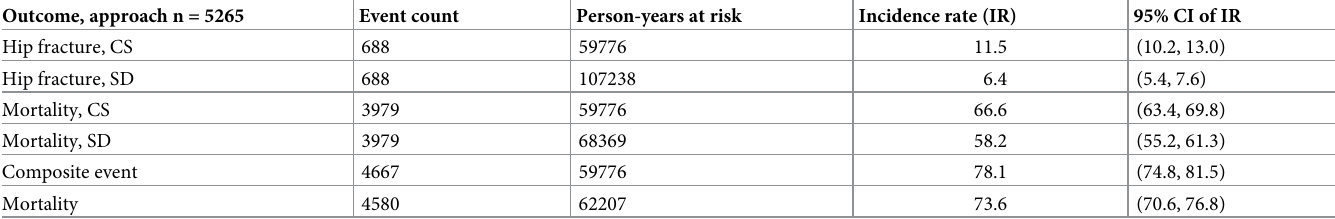
Table 2. Summary of CS and SD